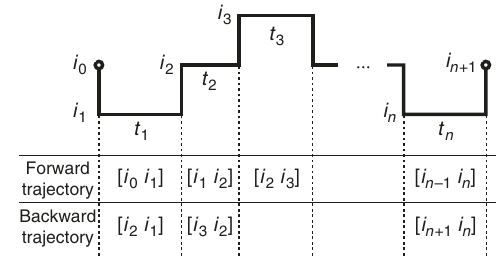
Fig. 6 A trajectory γ of a second-order semi-Markov